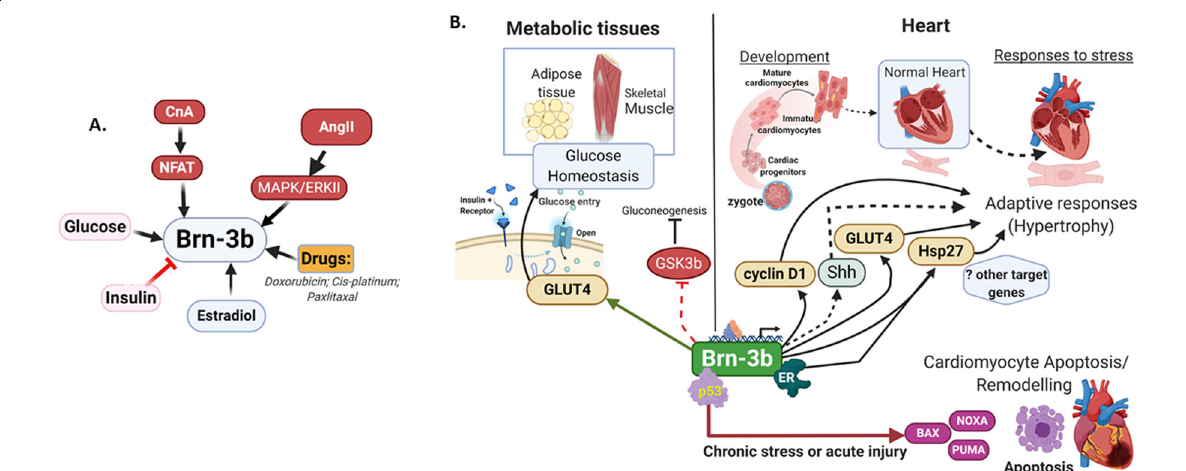
Fig. 4 Schematic diagram showing factors that regulate Brn-3b expression and tissue-speci fi c target genes that it may control in cardiac and metabolic tissues. A Schematic diagram showing growth effectors and signalling pathways that are known to regulate Brn-3b expression. Black arrows indicate activators; red bars indicate inhibitory effects. B Schematic diagram showing the proposed effects by which Brn-3b and its target genes can give rise to functional effects in either metabolic tissues or in the heart. High levels of Brn-3b in the foetal heart are reduced in normal adult hearts but signi fi cantly re-expressed in response to stress. Brn-3b target genes are associated with adaptive hypertrophic responses in the absence of p53. However, chronic stress or acute injury that induces p53 in Brn-3b expressing cells will cause cooperative activation of pro-apoptotic target genes, associated with cardiomyocyte apoptosis and remodelling. Solid arrows indicate genes that are directly regulated by Brn-3b while dotted arrows indicate proposed effects (activation or